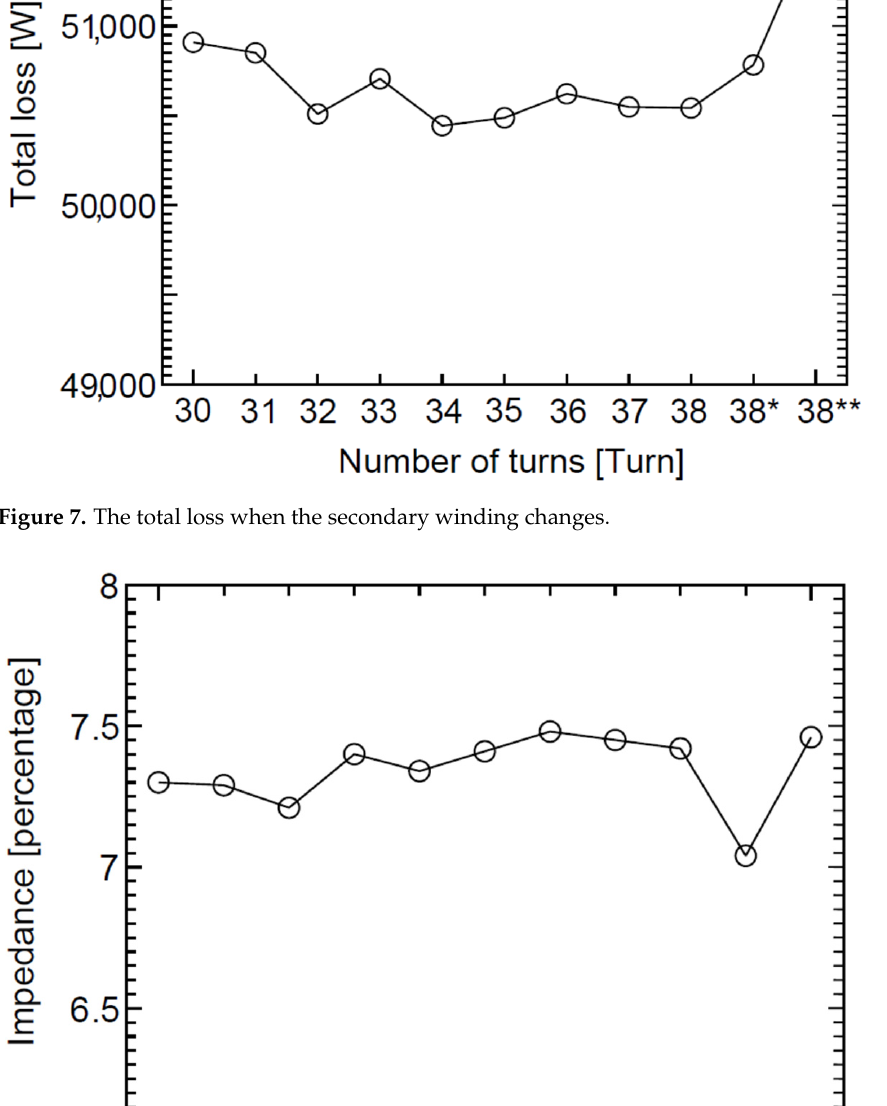
Figure 8. The percentage impedance when the secondary winding changes.